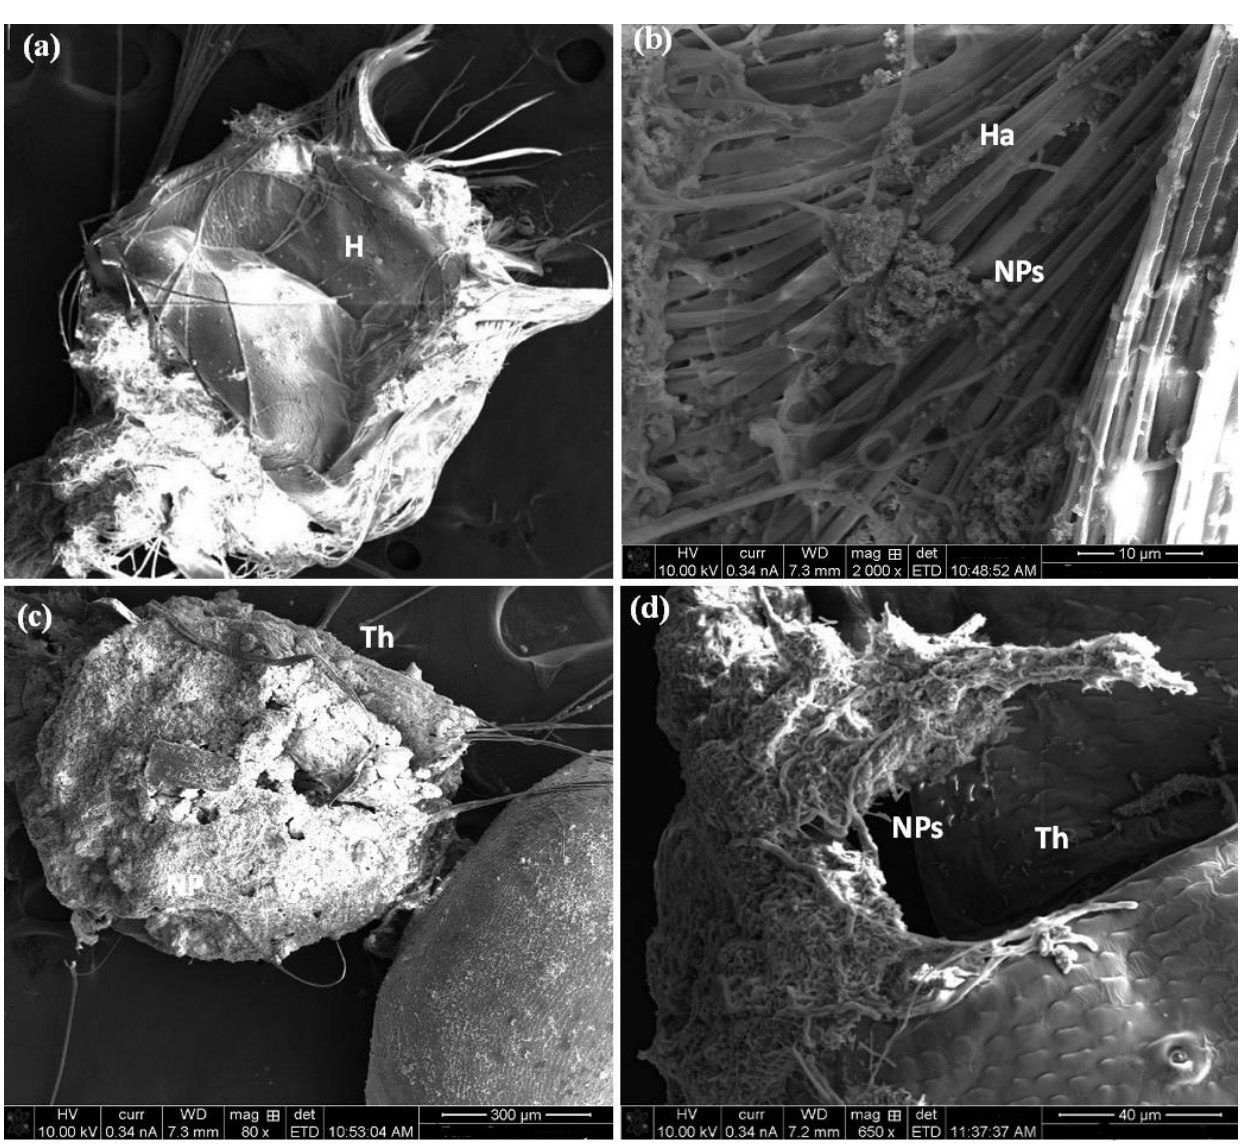
Figure 7. SEM of C. pipiens (body parts) exposed to Co 3 O 4 NPs. ( a , b ) show that Co 3 O 4 adheres to the head region and mouth parts. ( c , d ) display the NPs attached to the thoracic cuticle. (Th: thoracic, Cu: cuticle, H: head, Ha: head hair, Mp: mouthparts, NPs: nanoparticles).